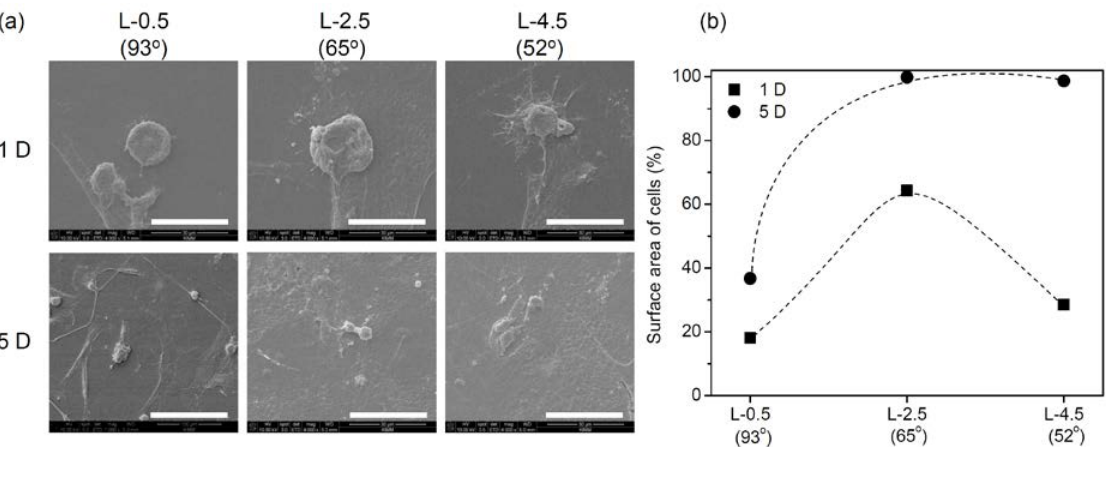
Figure 5. ( a ) Scanning electron microphotographs and ( b ) surface areas of hADSCs adhered to each gradient surface (L-0.5, L-2.5, and L-4.5) on days 1 and 5 (magnification: 4000×; scale bar: 30